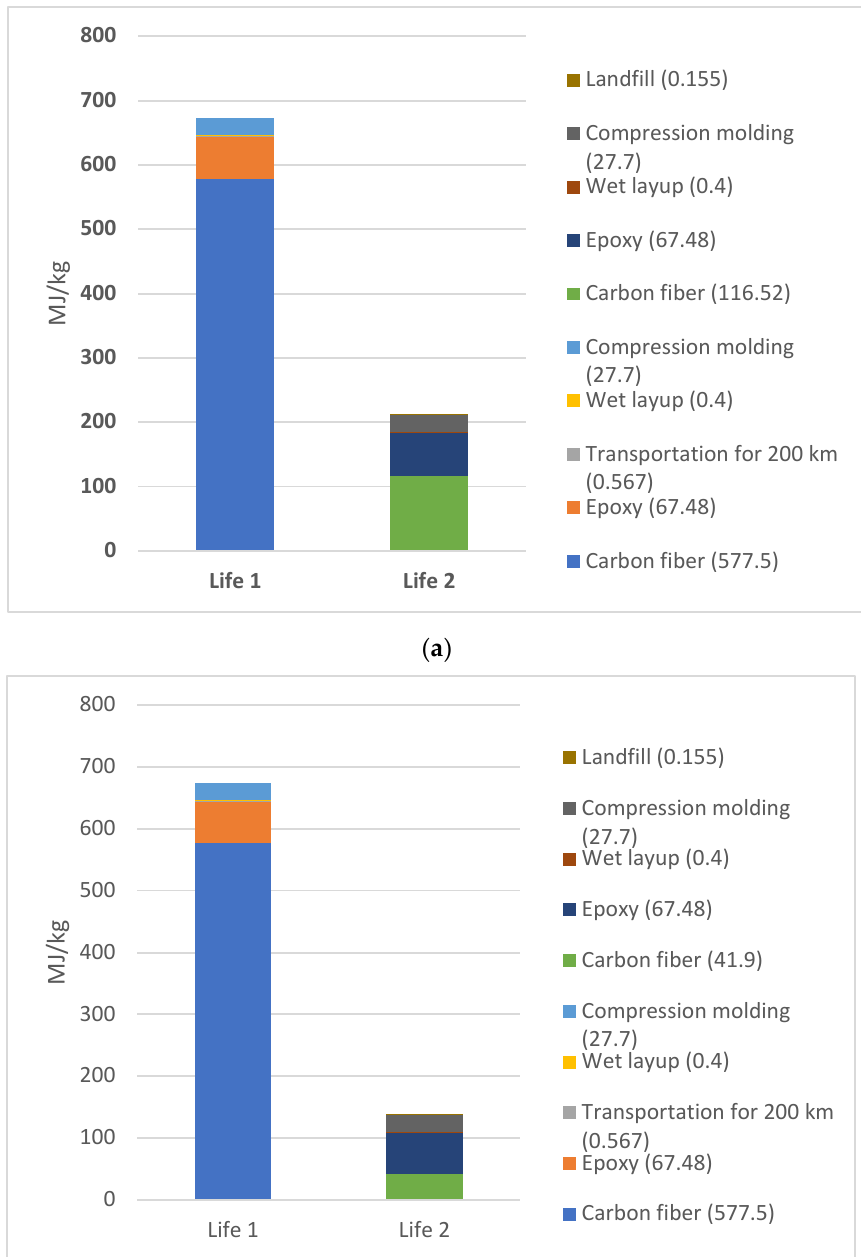
Figure 4. ( a ) Scenario 3a. EE comparison of Life 1 versus Life 2 for electric furnace scenario for pyrolysis; ( b ) Scenario 3B: EE comparison of Life 1 versus Life 2 for natural gas furnace scenario for pyrolysis.